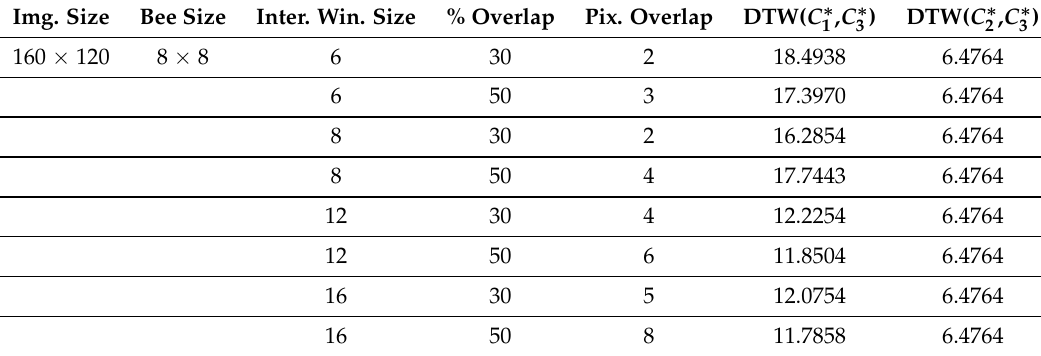
Table A15. DTW values for NT _ Vid . mp 4 with image size of 160 × 120; C ∗ and C ∗ is Human Count (ground 3